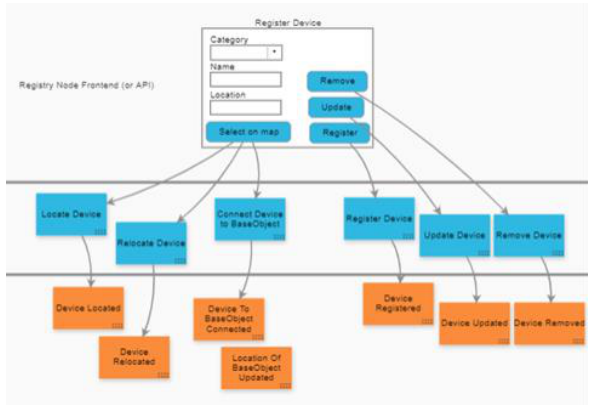
Figure 5 . Eventmodeling of Device